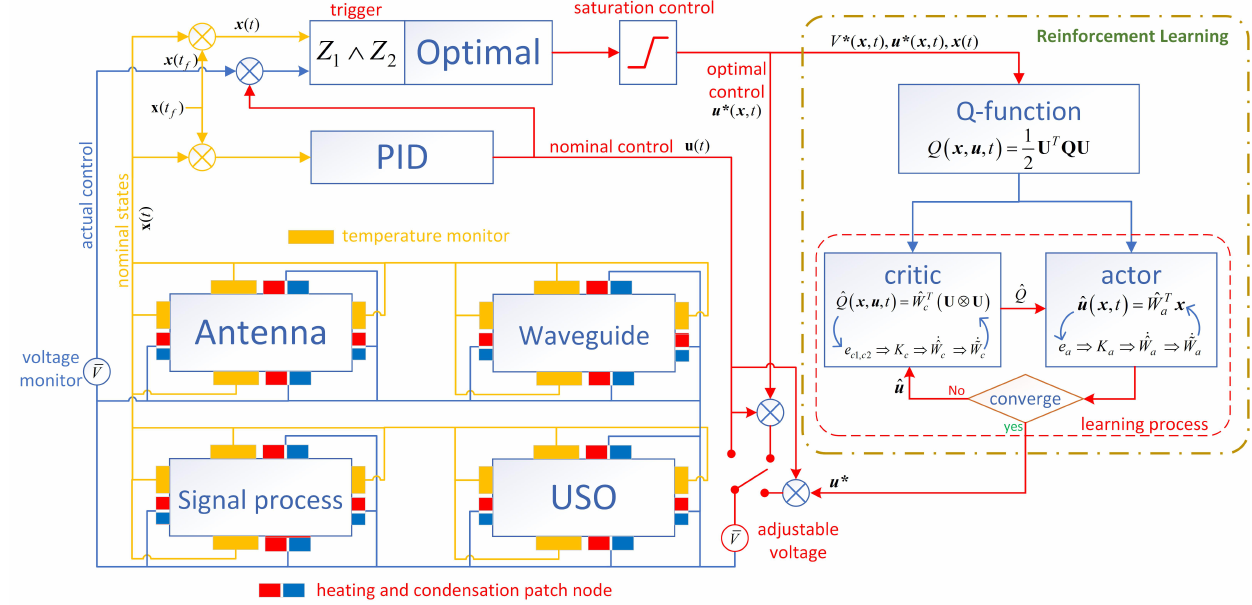
Figure 3. Structure of the triggered thermal control system with learning